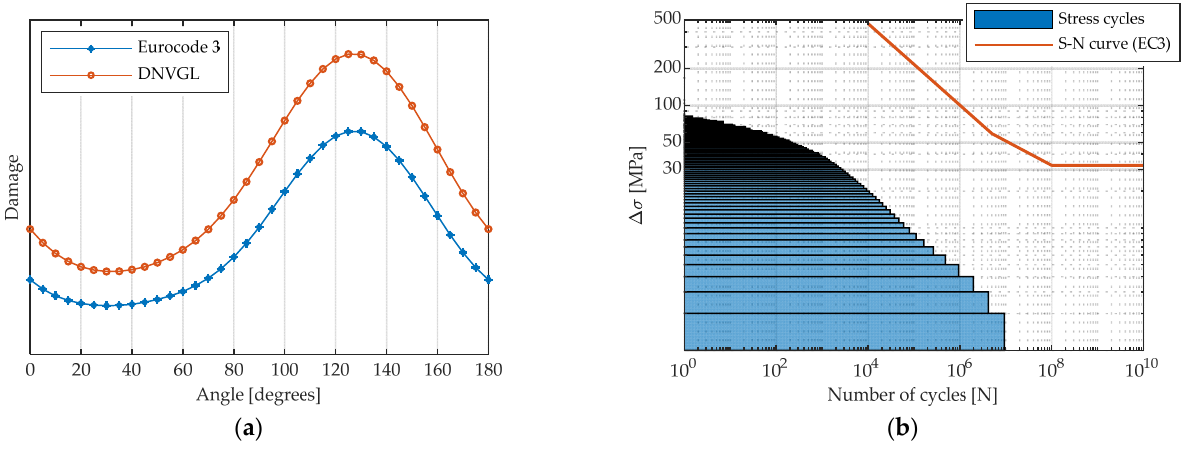
Figure 14. Influence of the S-N curve parameters: ( a ) damage distribution over the section (y scale omitted due to confidentiality agreements); and ( b ) histogram of the stress cycles and S-N curve provided by Eurocode 3.